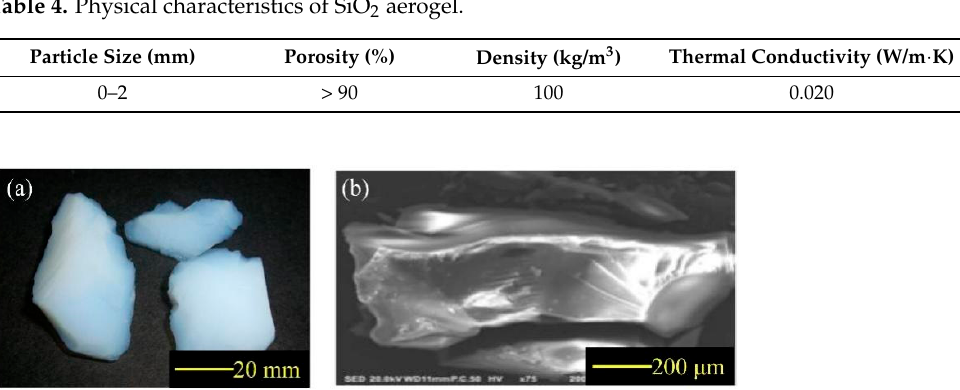
Figure 1. Aerogel: ( a ) macroscopic morphology; ( b ) SEM image.